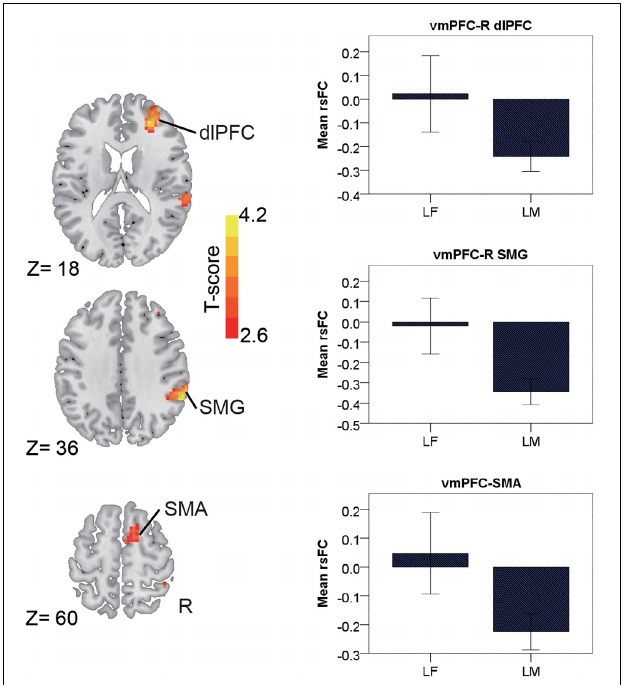
FIGURE 5 | Regions showing the gender differences in the late-adulthood stage detected by two-sample t -test (with a permutation test correction threshold of p < 0.05) in the vmPFC(–) network, each with the corresponding mean strength between the seed and region for the males and females shown in the bar plot, error bars indicated two standard errors (vmPFC, ventromedial prefrontal cortex; dlPFC, dorsolateral prefrontal cortex; SMG, supramarginal gyrus; SMA, supplementary motor area; R, right).